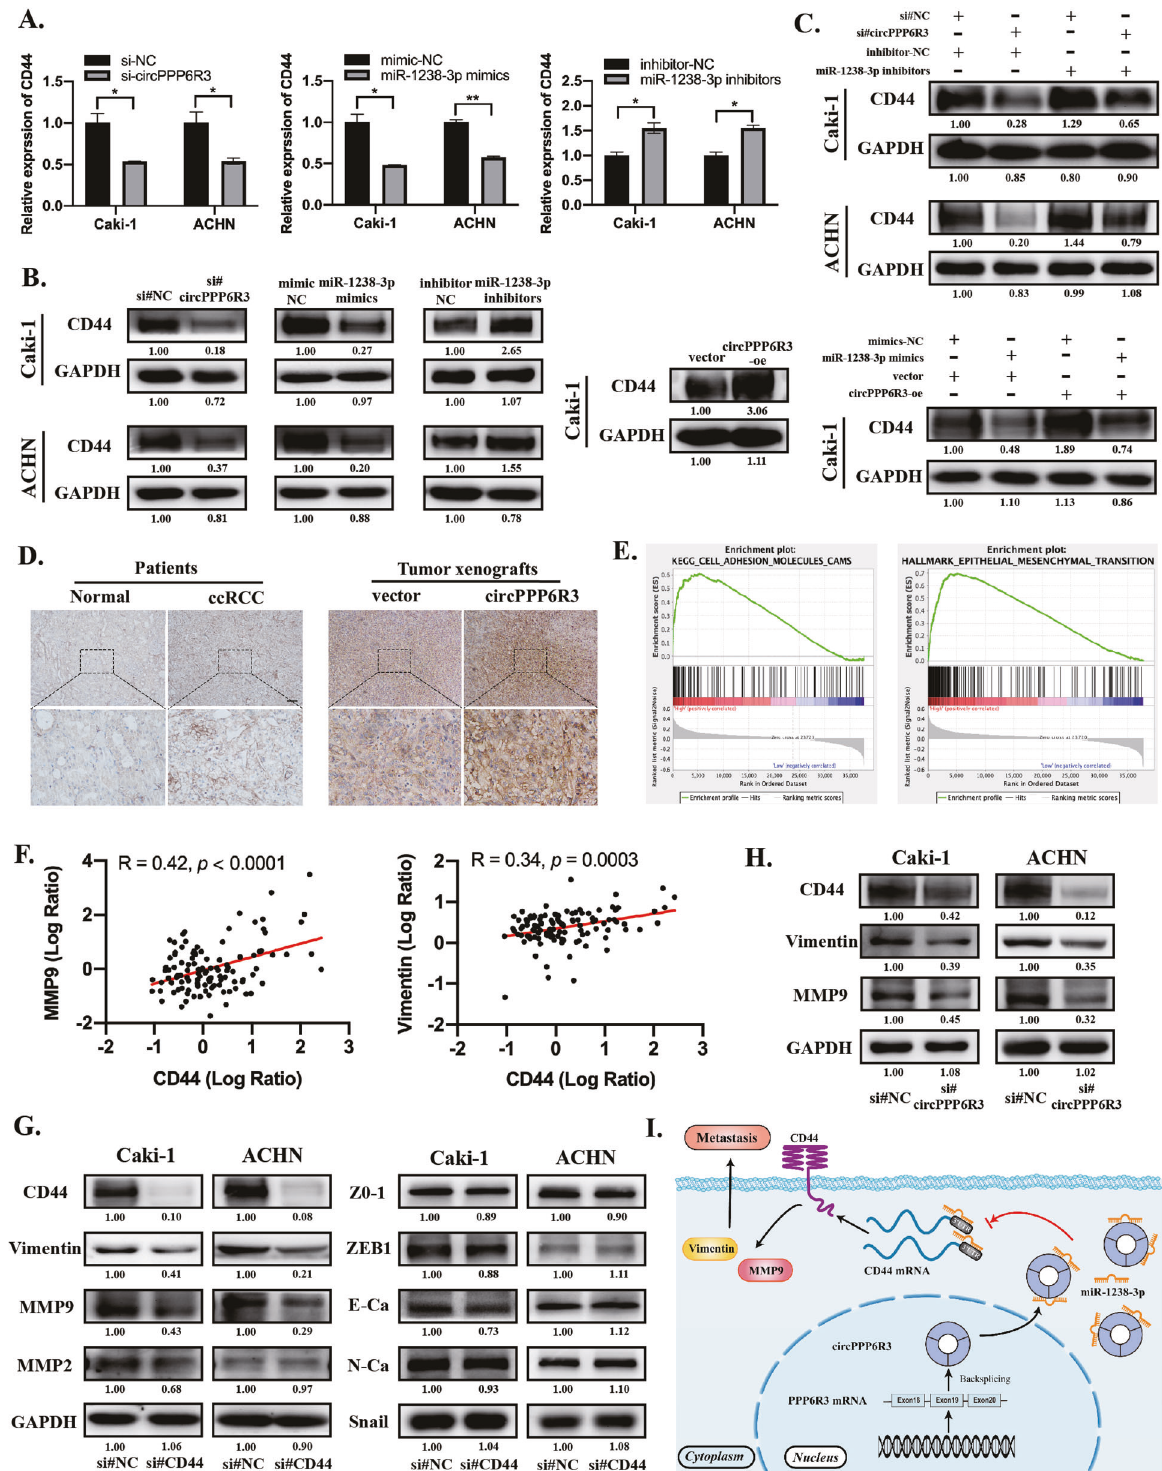
Fig. 7 circPPP6R3 upregulated CD44 via sponging to miR-1238-3p. A , B qRT-PCR and Western Blotting were conducted to detect the relative expression of CD44 in ccRCC cells treated with siRNAs and overexpressing plasmids for circPPP6R3, mimics, and inhibitors for miR- 1238-3p. C The circPPP6R3-knockdown-induced diminishment of CD44 was attenuated by miR-1238-3p inhibitors in ccRCC cells. D Representative IHC images of CD44 in ccRCC tissues as well as xenografts tumor tissues in animal studies. Scale bars, 50 μ m. E GSEA was performed to identify the downstream pathway of CD44 in TCGA patients based on the high and low expression of CD44. F Correlation analysis of the protein level between CD44 and MMP9, Vimentin from the database in CPTAC. G , H MMP9 and Vimentin were downregulated in CD44-silencing or circPPP6R3-silencing ccRCC cells. I Schematic diagram illustrating the biological functions and mechanisms of the regulatory axis of circPPP6R3/miR-1238-3p/CD44 in ccRCC progression.